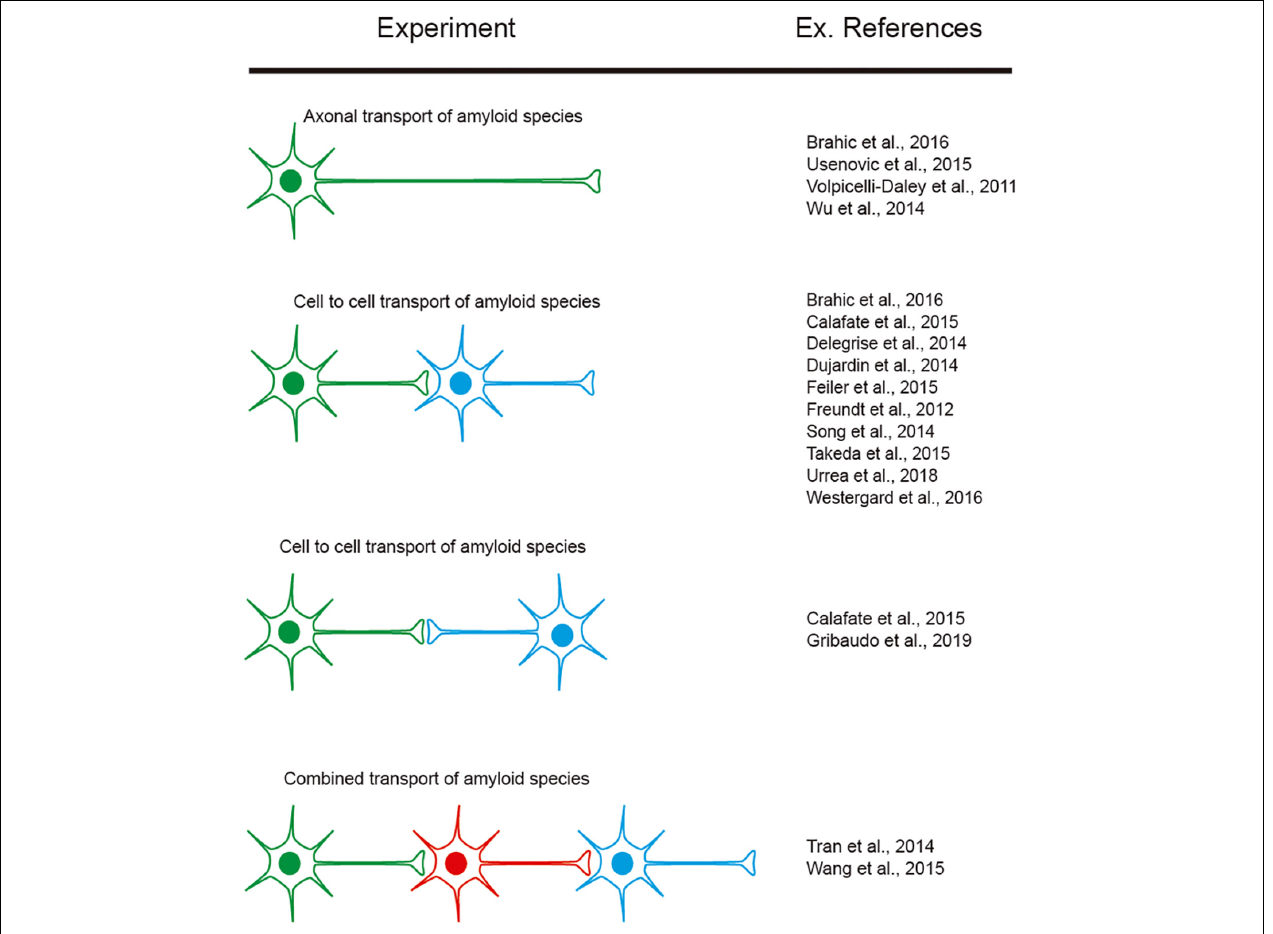
FIGURE 5 | Examples of experiments designed to explore amyloid transport in axons as well as cell-to-cell transmission. The different colors of the illustrated cells represent the cells cultured in different reservoirs of compartmentalized LOC devices and their orientation. In addition, some references are included as examples of their exponential use in neurodegenerative